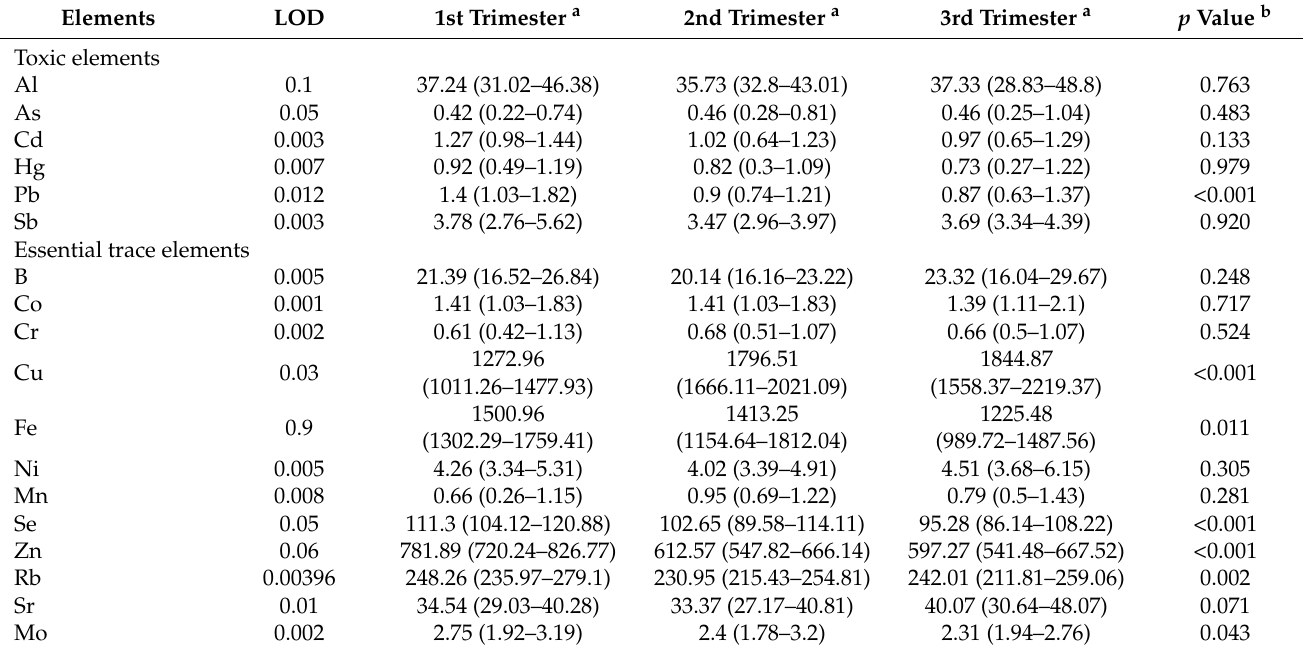
Table 2. Concentration of trace elements in maternal blood (MB) during